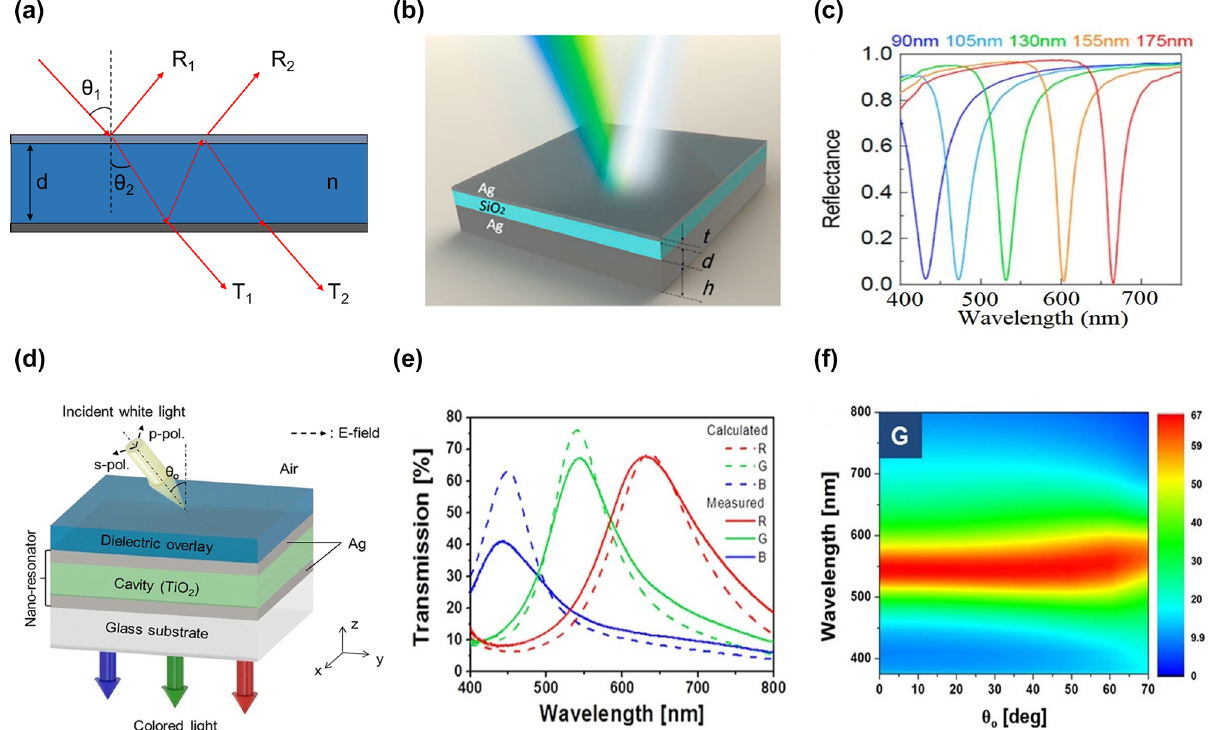
Figure 5: FP resonance for structural color generation. (a) Schematic diagram of a typical FP cavity model, which is composed of two metal mirrors and a dielectric layer between them. Here, n and d respectively represent refractive index and thickness of the dielectric layer. 𝜃 angles of incidence and refraction at the metal/dielectric interface on the input side, respectively. (b) Schematic diagram of the Ag-SiO cavity. Here, t , d , and h represent thickness of the top Ag, the middle SiO with the cavity length d ranging from 90 nm to 175 nm. The top and bottom Ag layer thicknesses are fixed as 30 and 100 nm, respectively. Modified with permission [101]. Copyright 2015, American Chemical Society. (d) Schematic diagram of the TiO structural color generation. (e) The calculated (dashed curves) and measured (solid curves) transmission spectra of the red, green and blue colors, cavity lengths are set as 100 nm, 75 nm, and 50 nm, respectively. Thicknesses of the over-coated TiO where the TiO 2 bottom Ag layer are respectively fixed as 60 nm, 23 nm, and 23 nm for all designs. (f) Angularly-resolved transmission spectra of the green-color device under p-polarized illumination. The device exhibits close-to-identical transmission spectra as the illumination angle increases up to 70 ◦ . Reproduced with permission [103]. Copyright 2015, Nature Publishing